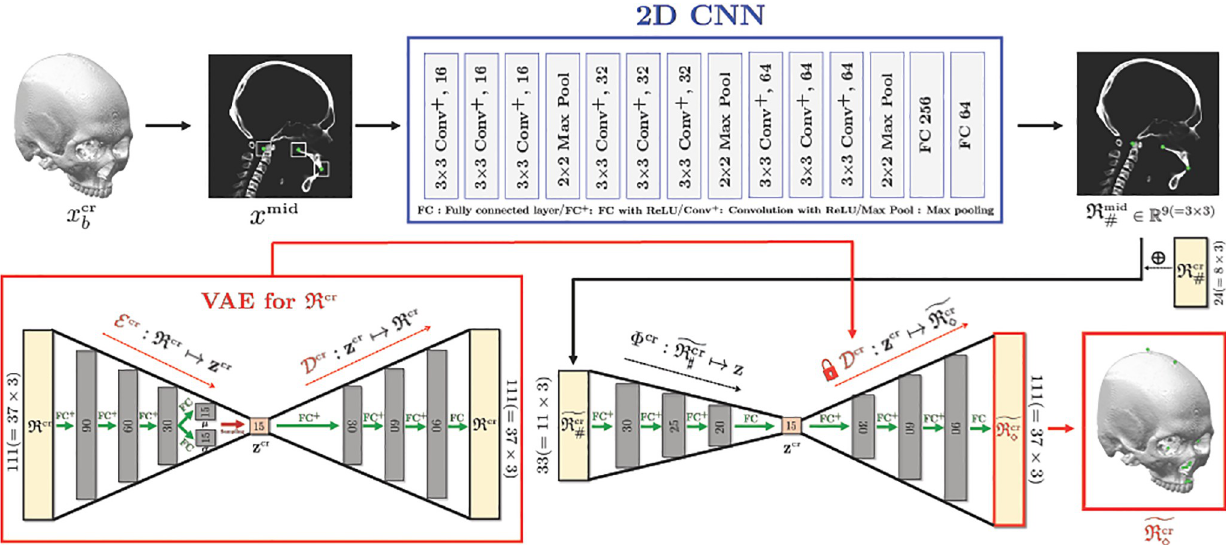
Fig 5. 3D cranial landmark detection using VAE-based low dimensional representation combined with easy-to-find landmarks. Here, the entire cranial landmarks R cr are estimated directly from the knowledge of the reference landmarks R cr obtained by 2D